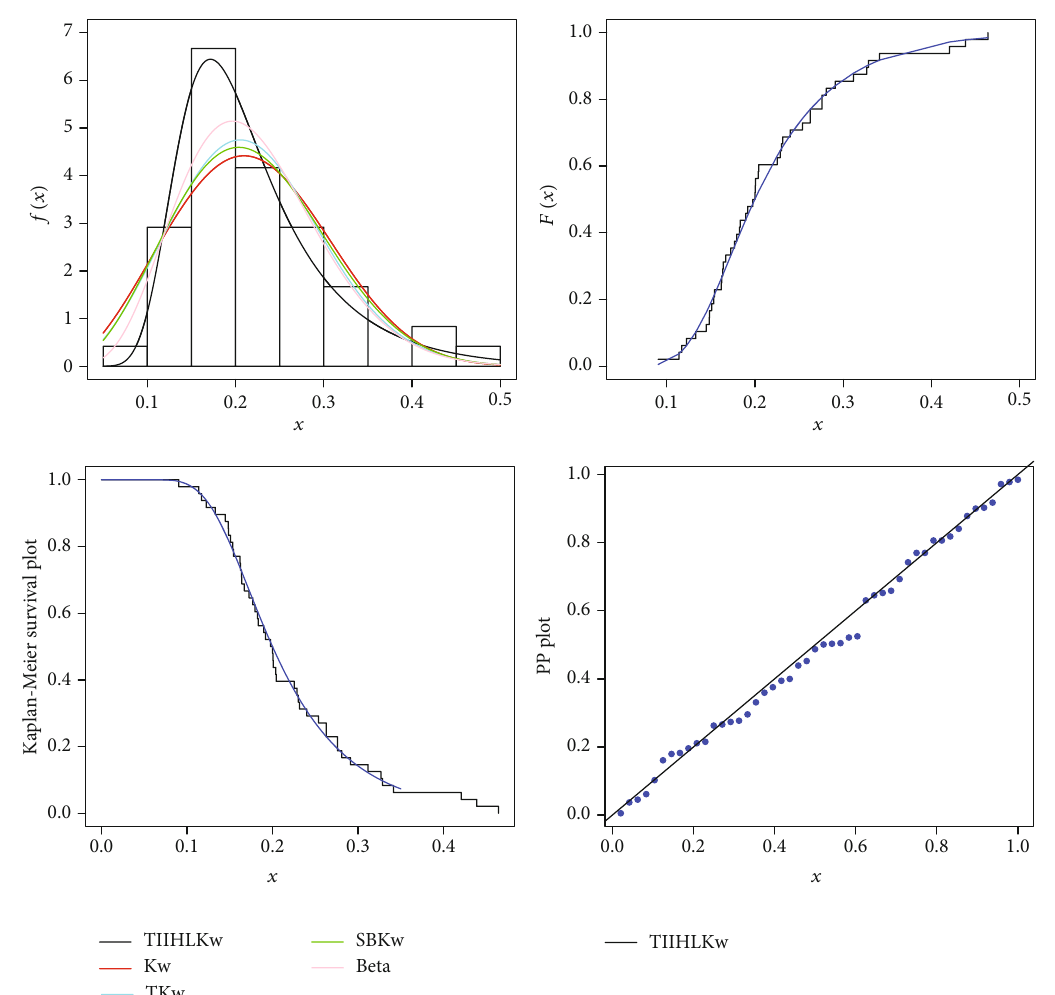
Figure 8: The fi tted pdf, cdf, survival, and PP plots of the TIIHLKw distribution for second